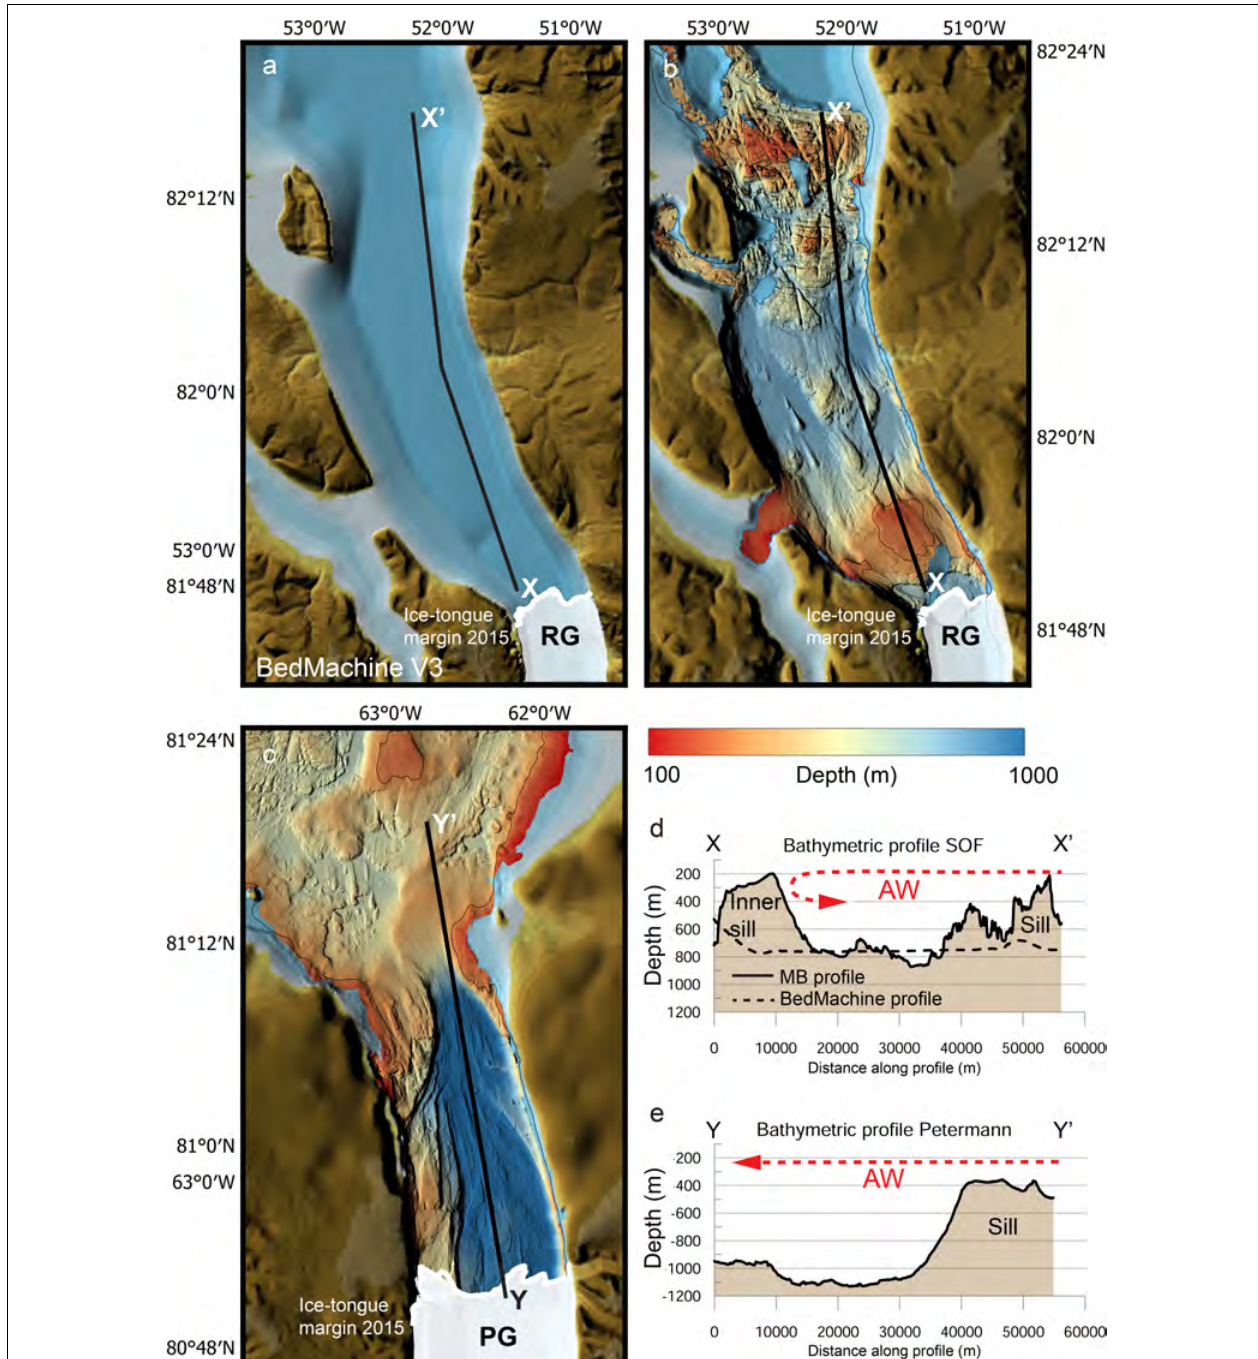
FIGURE 4 | Comparison between the bathymetry of Sherard Osborn Fjord hosting Ryder Glacier and Petermann Fjord where Petermann Glacier drains. (a) The BedMachine V3 gridded bathymetry of Sherard Osborn Fjord, which due to the complete absence of depth data at the time of compilation solely is based on extrapolating the depth of the Ryder Glacier’s grounding line to the first available depth soundings outside the fjord (Morlighem et al., 2017). (b) Multibeam bathymetry of Sherard Osborn Fjord revealing a complex seafloor morphology including an inner less than 200 m deep sill, which shields Ryder Glacier from inflowing warmer Atlantic water (Jakobsson et al., 2020b). (c) Multibeam bathymetry of Petermann Fjord, showing an outer prominent sill, which does not provide any significant protection from the inflowing Atlantic water. (d,e) Bathymetric profiles along Sherard Osborn and Petermann fjords based on the multibeam bathymetry visualize the different sill configurations. The effects from the sills on the inflowing warmer Atlantic water in both fjords are illustrated by red arrows. A bathymetric profile constructed in Sherard Osborn Fjord from BedMachine is shown with a stippled line in panel (d) to highlight the importance of knowing the seafloor when accessing the critical ice-ocean interactions for predictions of future sea-level